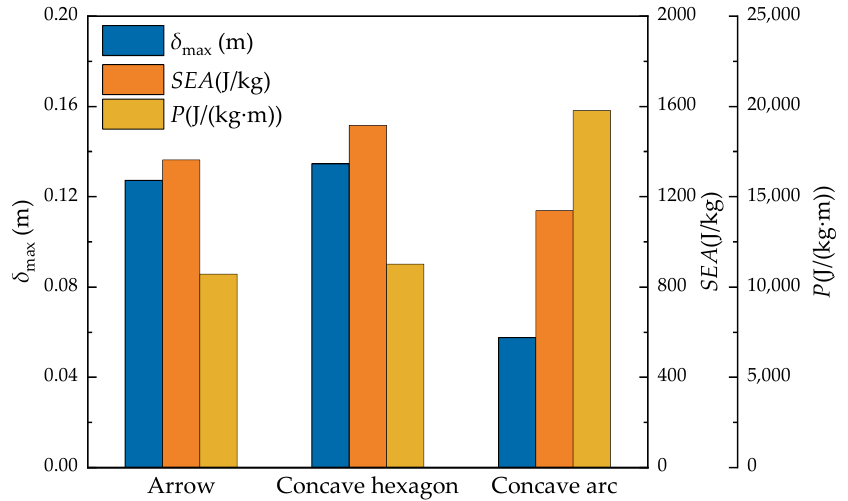
Figure 10. Anti-blast indices of three honeycomb structures.